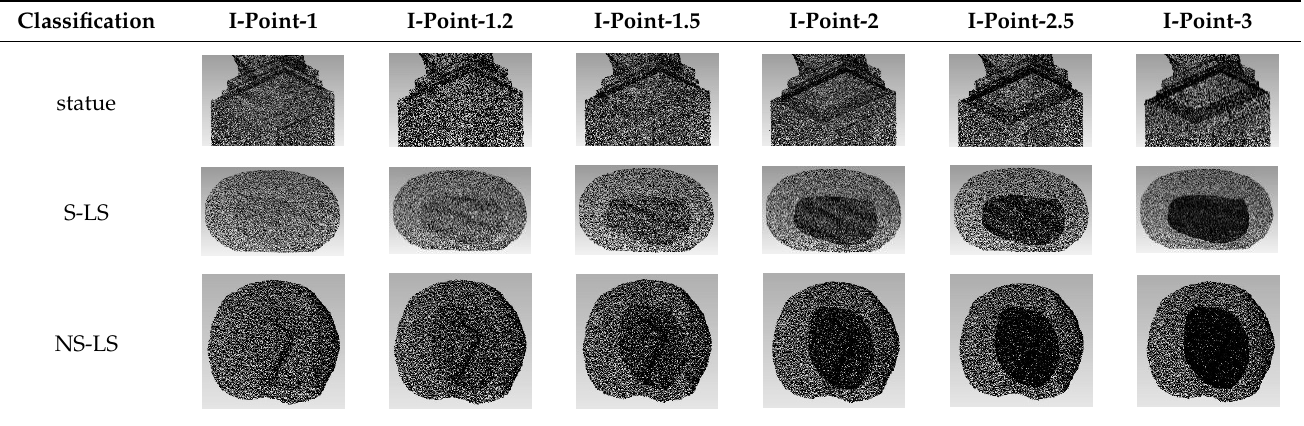
Table 3. The registration results of two kinds of data.